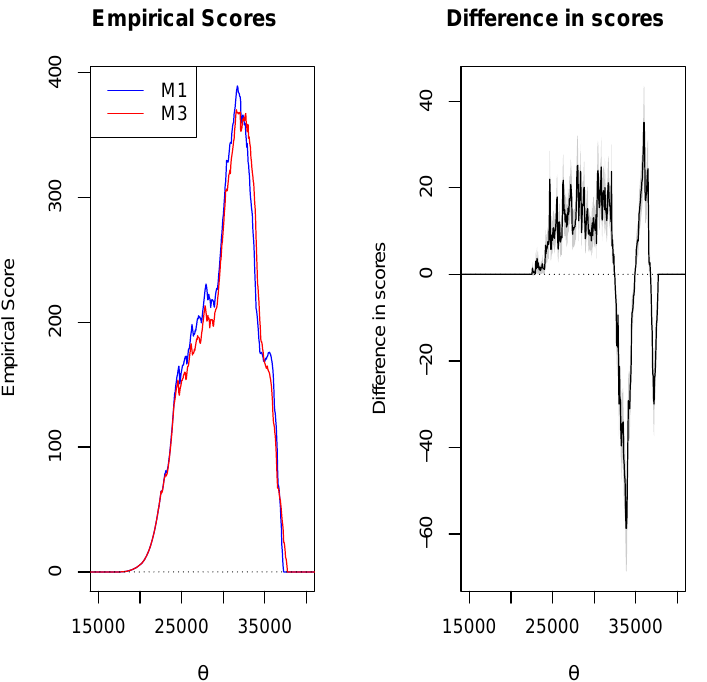
Figure 11. Murphy diagrams for the comparison of the 0.99 quantiles of AQR99 and NLQR99 (M1 and